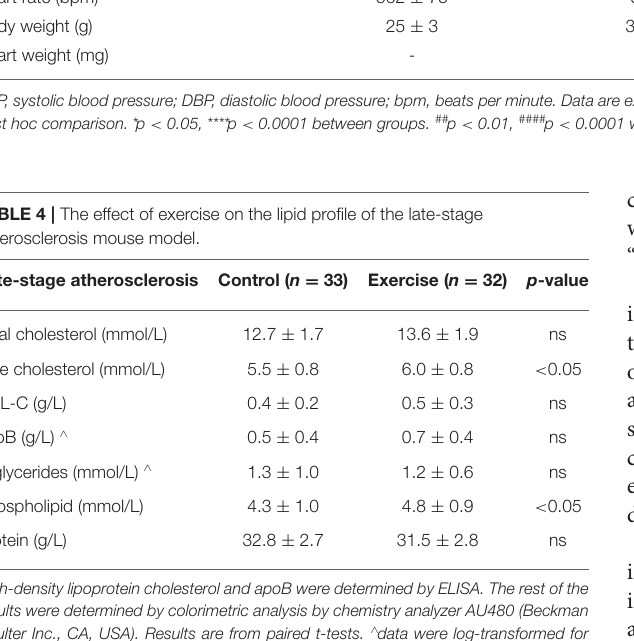
High-density lipoprotein cholesterol and apoB were determined by ELISA. The rest of the results were determined by colorimetric analysis by chemistry analyzer AU480